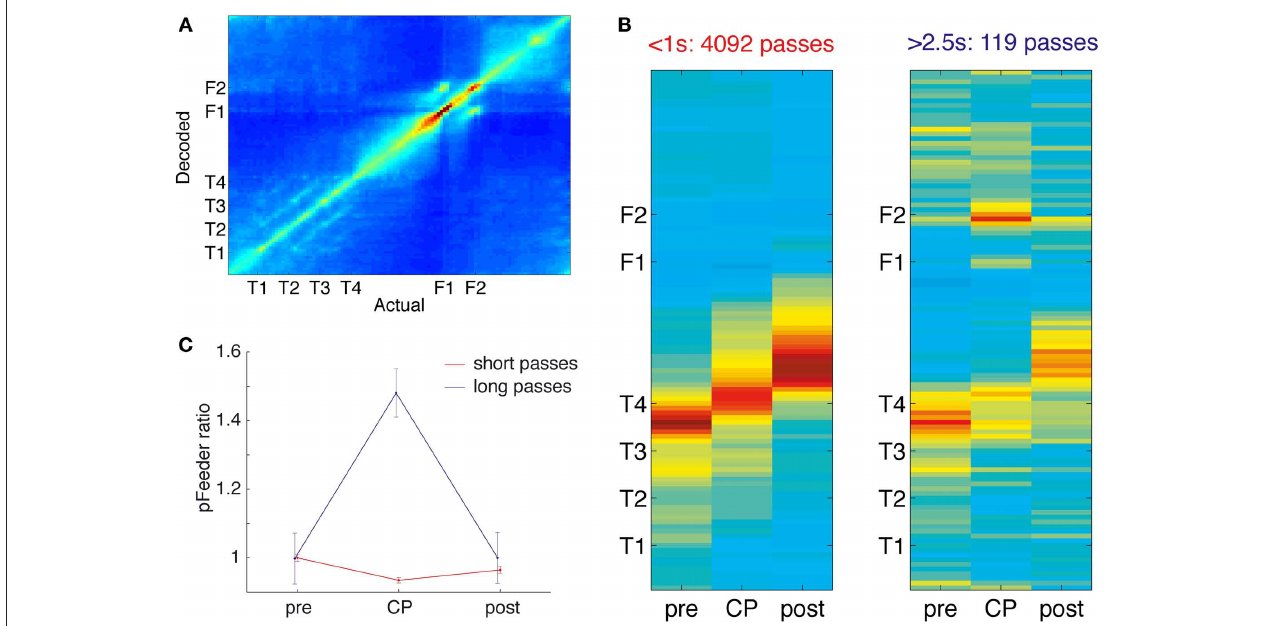
FIGURE 6 | Decoding of ventral striatal ensembles reveals increased representation of rewarded locations as rats pause at the choice point. (A) Average posterior (decoded) spatial probability distribution as a function of actual location. Cold colors indicate low, hot colors high decoding probability. (B) Posterior probability distributions for short (left panel) and long (right panel) passes through the choice point (CP). The three columns in each panel correspond to the 0.5 s immediately preceding